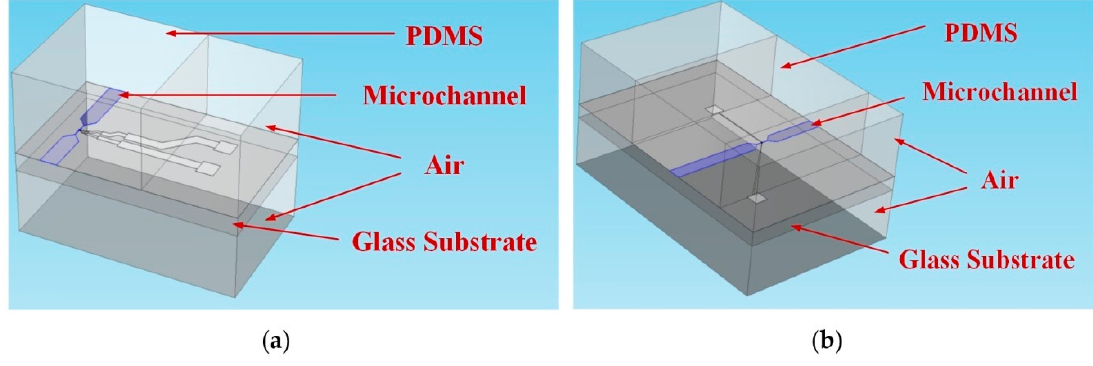
Figure A2. Simulated electrode structures: ( a ) first-generation sensor and ( b ) second-generation sensor.